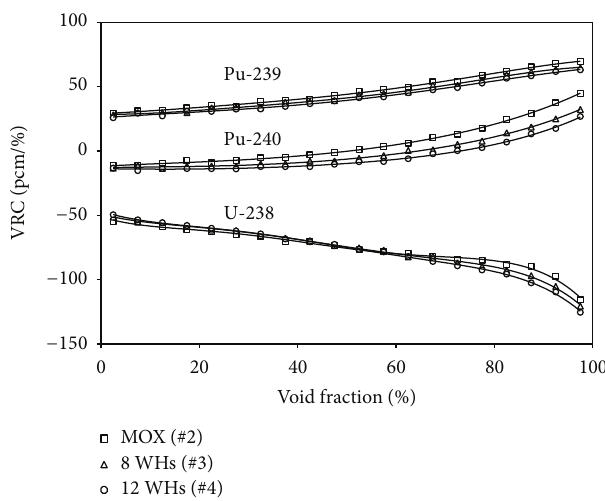
Figure 11: Values of void reactivity coefficients for separate isotopes in modified MOX fuel